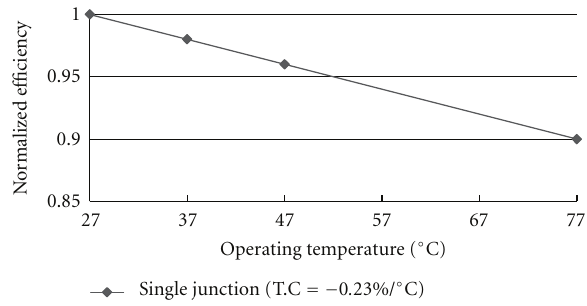
Figure 4: Operating temperature